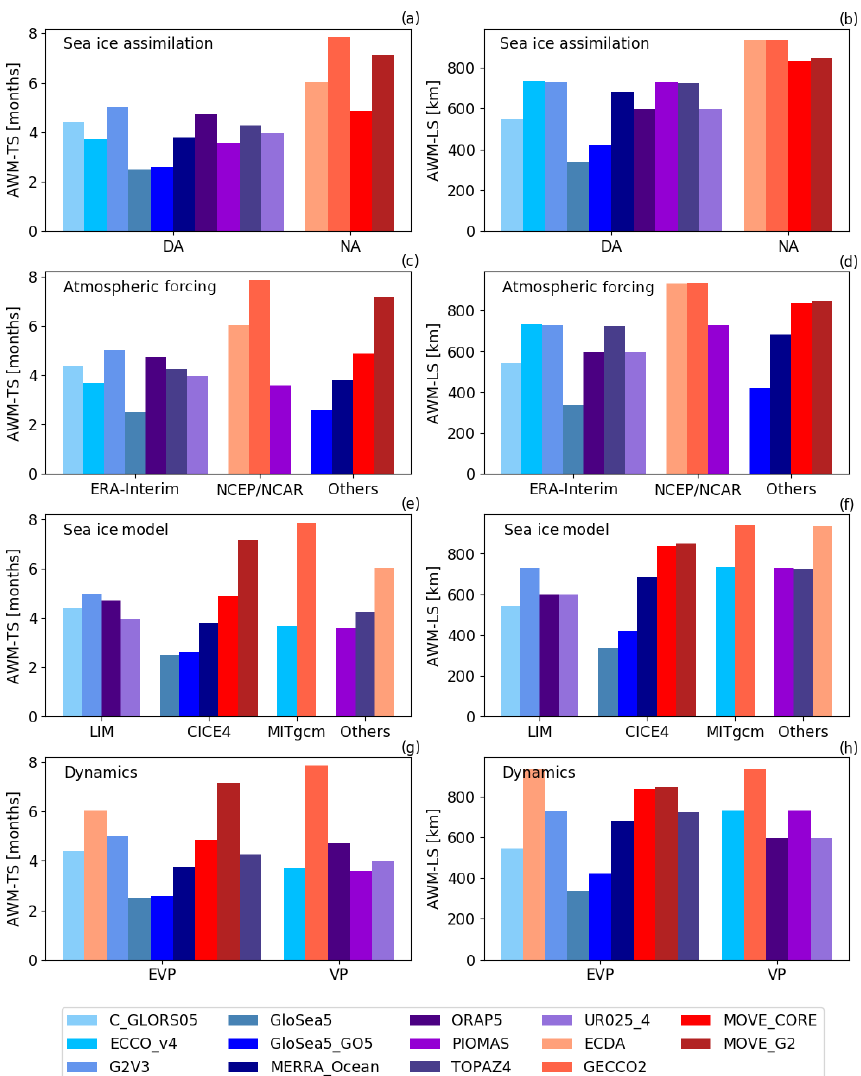
Figure 12. Histograms showing how the AWM timescale (left-hand panels) and AWM length scale (right-hand panels) are related to different reanalysis specifications: (a–b) whether or not the system assimilates sea ice data, (c–d) the source of atmospheric forcing data, (e–f) the sea ice model used, and (g–h) the dynamics used (viscous–plastic or elastic–viscous–plastic) for ice–ice interactions that control ice deformation. Shades of blue and purple indicate the reanalyses which do assimilate sea ice data, while shades of red indicate the reanalyses without sea ice data